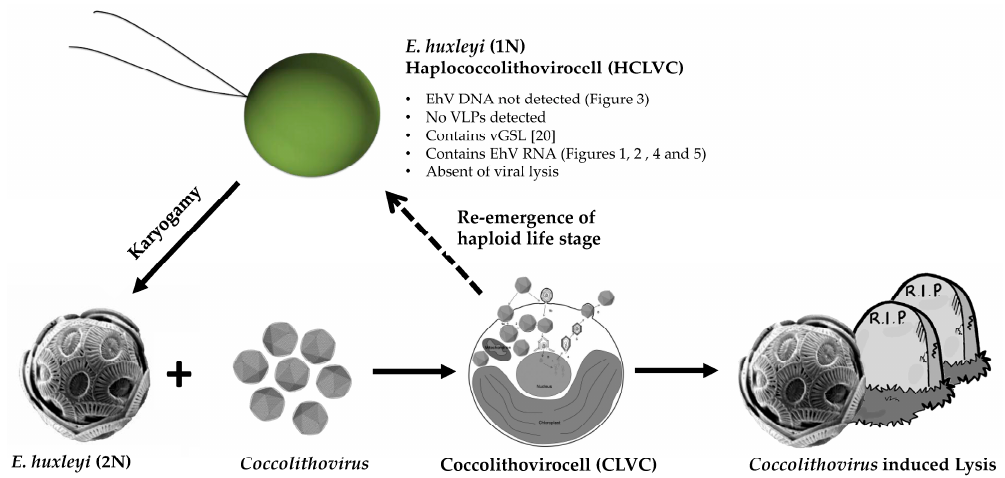
Figure 6. Proposed new Coccolithovirus - E. huxleyi life cycle incorporating the Haplococcolithovirocell. Infected diploid cells either undergo viral induced lysis or re-emerge as haploid cells containing viral RNA and lipids. Images: CLCV adapted from Mackinder et al. [37], Coccolithoviruses adapted from ViralZone [46]. vGSL: viral glycosphingolipids; VLP: virus like particles.